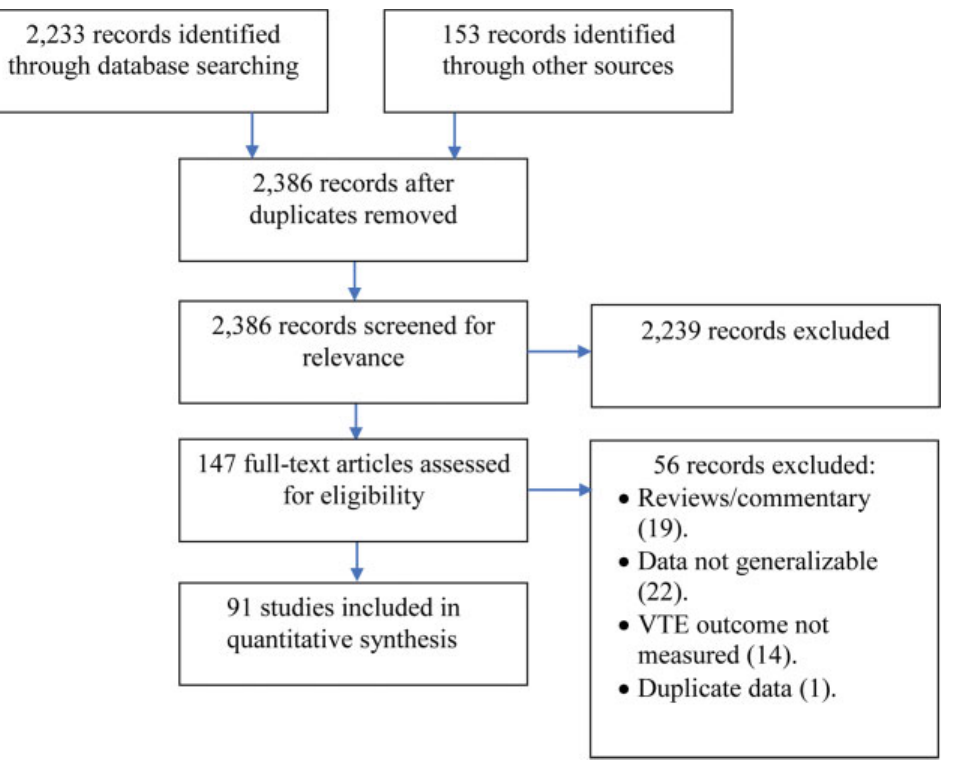
Fig. 1 Preferred reporting items for systematic reviews and meta-analyses (PRISMA) fl ow diagram for study selection. VTE, venous